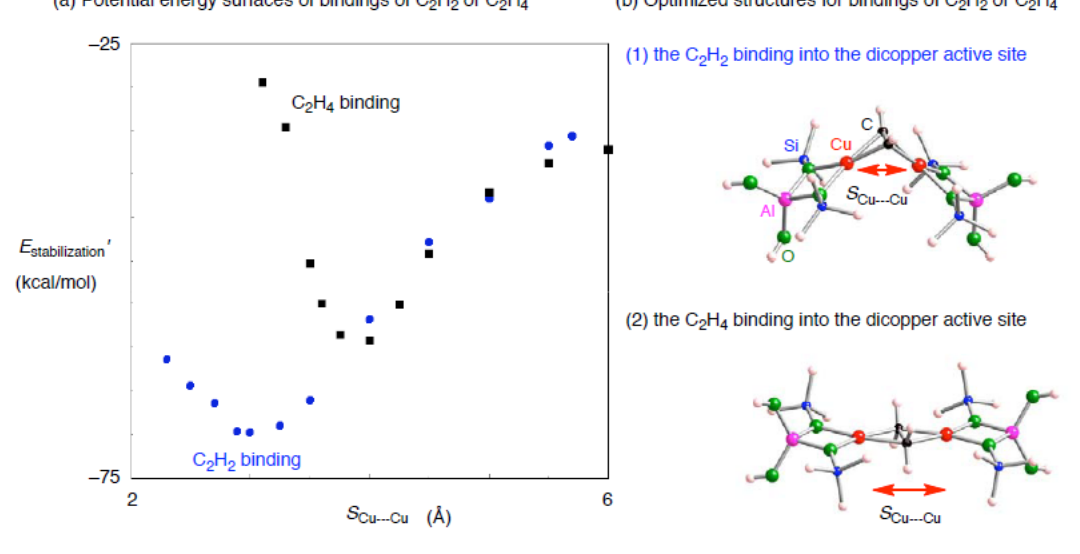
H or (2) C H ) into the small dicopper zeolite model. 2 2 2 4